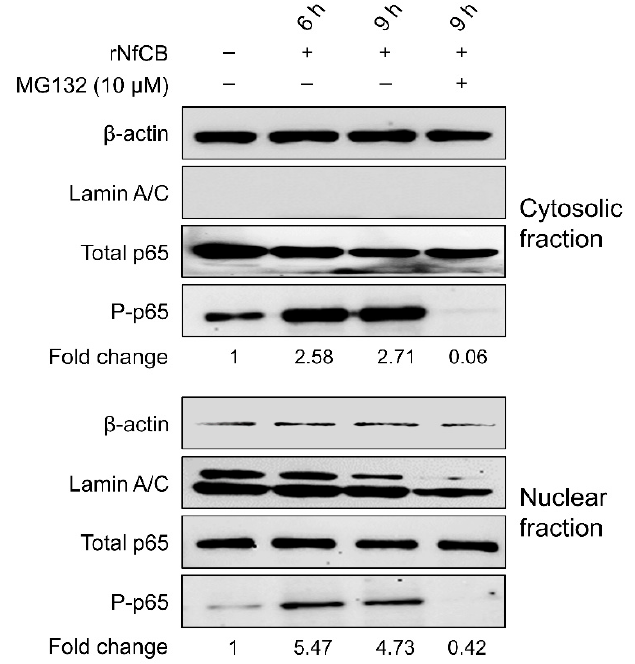
Figure 7. Phosphorylation and nuclear translocation of p65 in rNfCB-stimulated BV-2 microglial cells. To analyze phosphorylation level and translocation of p65, BV-2 microglial cells were treated with rNfCB (100 µ g/mL) with or without pre-treatment with MG132. Cytoplasmic proteins and nuclear proteins were extracted from the cells separately. Phosphorylation of p65 was analyzed by immunoblot using a specific antibody for each protein. β -actin and Lamin A/C were used as internal controls. Fold-change means relative density change of P-p65 compared to negative control without treatment of rNfCB and inhibitor.